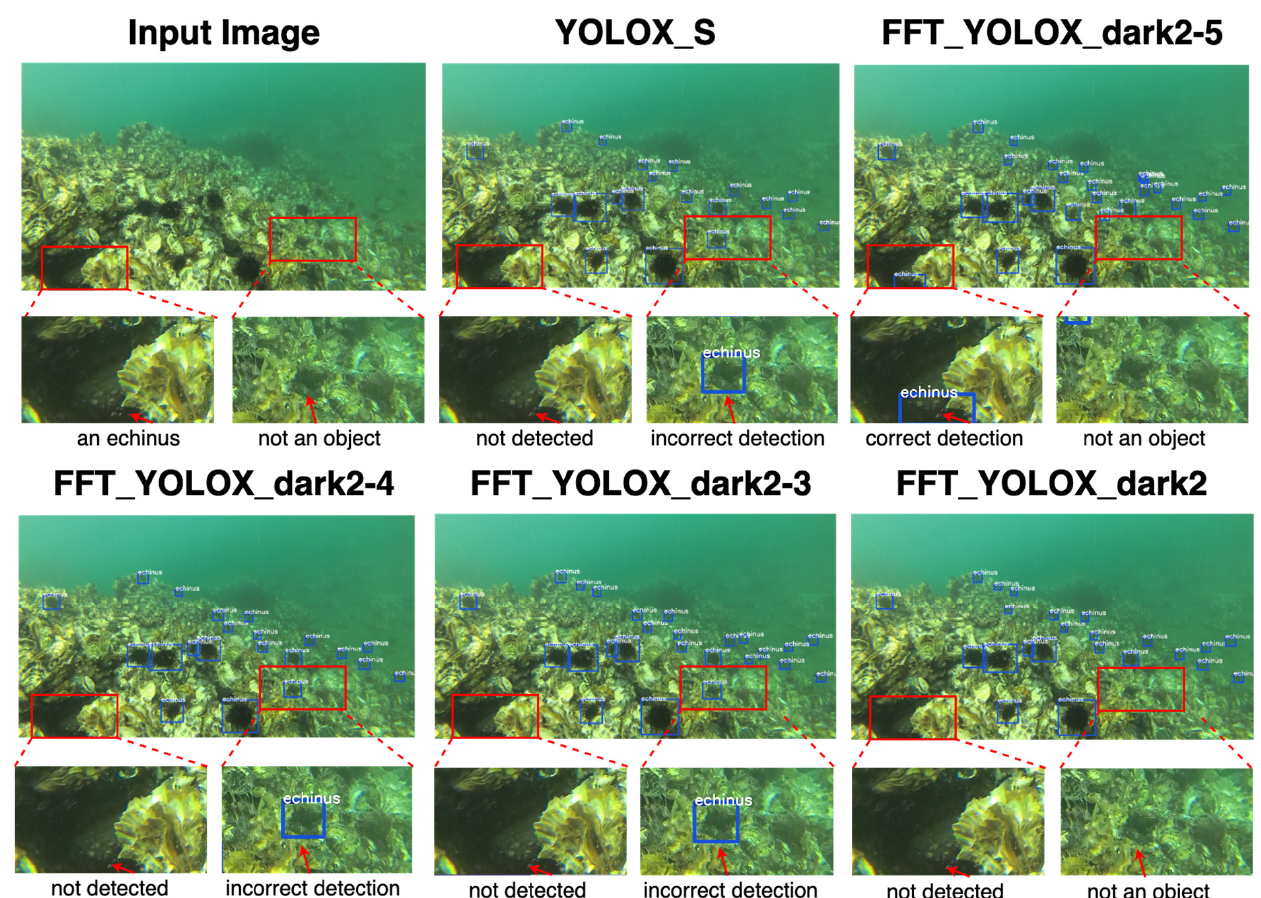
Figure 6. The enlarged important areas of the detection results of different models.